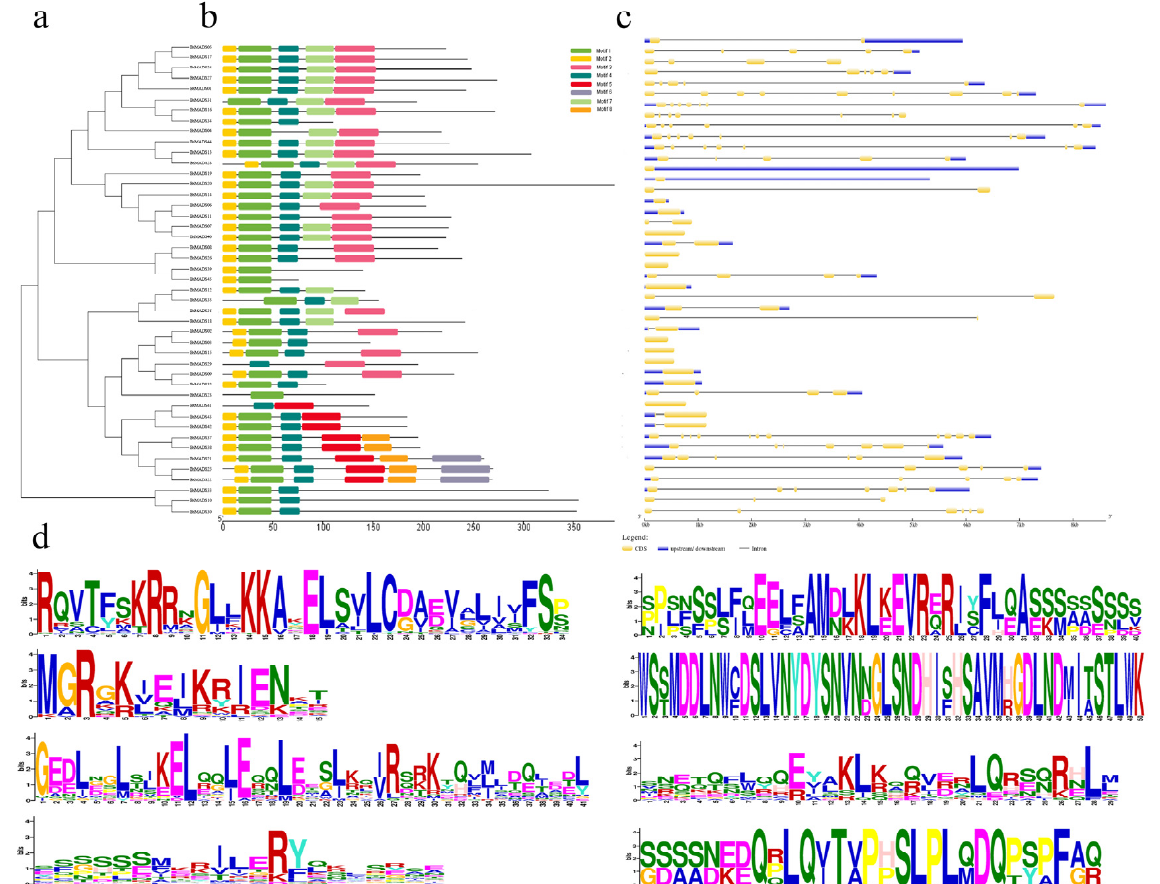
Figure 4. Phylogenetic relationships, conserved motifs, and exon–intron organization of MADS genes: ( a ) the phylogenetic tree contained 45 MADS proteins (named BsMADS01 to BsMADS45) from B. striata . ( b ) The motif patterns of the 45 BsMADS proteins. Each motif is shown as boxes of different colors. ( c ) Exon–intron structures of MADS genes from B. striata . Exon(s) and intron(s) are represented by yellow boxes and black lines, respectively, while the untranslated regions are represented by blue boxes. The number manifested the phases according to the BsMADSs introns. ( d ) Sequence logos of each motif.